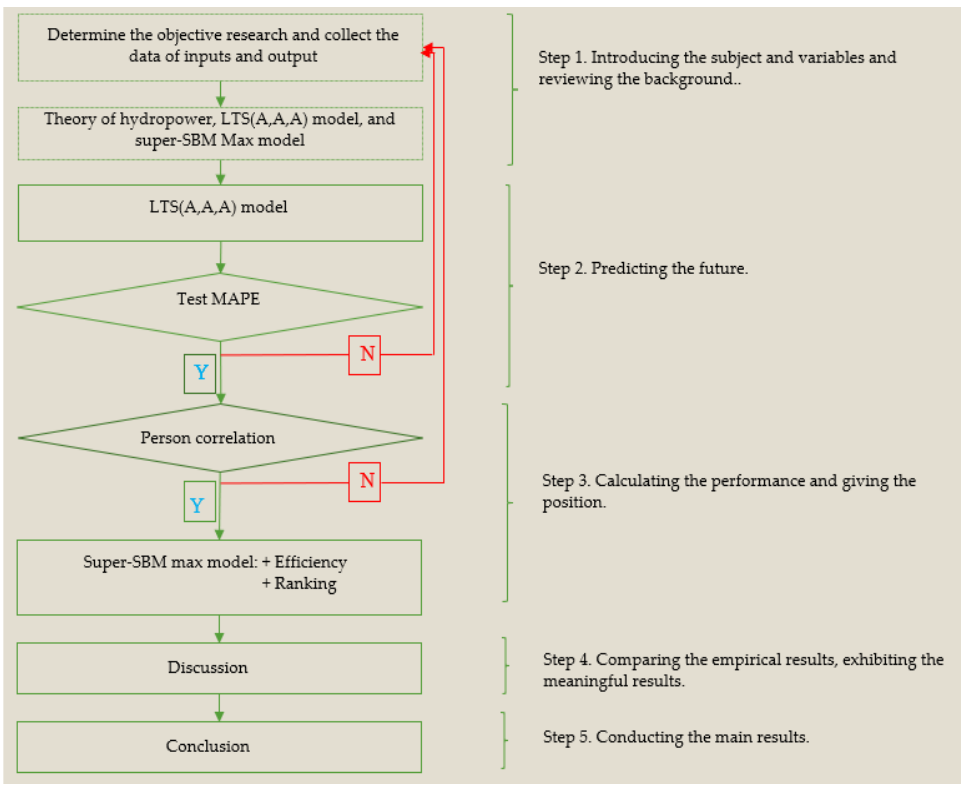
Figure 1. Proposal research.